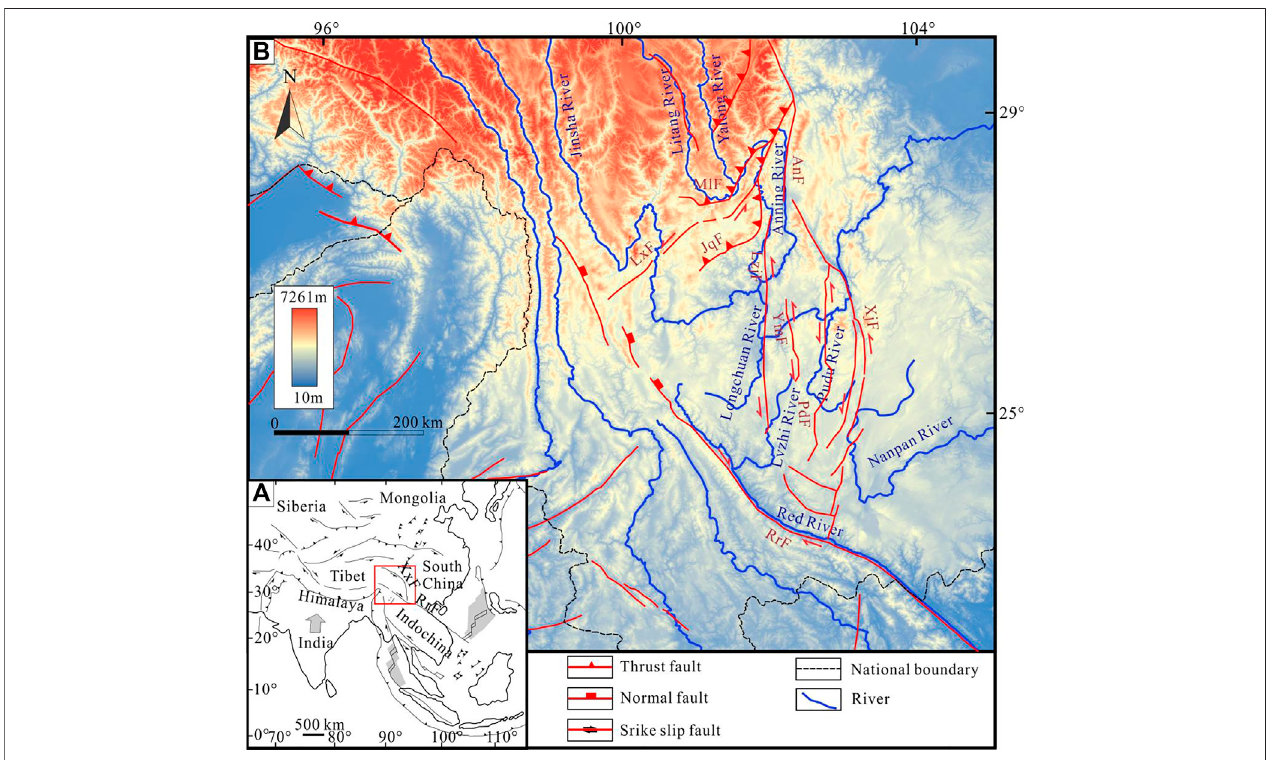
FIGURE1| Topographic map oftheCentralYunnan subblock. (A) Location ofthe study area. (B) Topography, majorfaults,and rivers inthe southeastern Tibetan Plateau. XxF , Xianshuihe – Xiaojiang Fault; AnF , Anninghe Fault; LxF , Lijiang – Xiaojinhe Fault; MlF , Muli Fault; JqF , Jinhe – Qinghe Fault; LzjF , Lvzhijiang Fault; YmF , Yimen Fault; PdF , Pudu Fault; XjF , Xiaojiang Fault; RrF , Red River Fault.